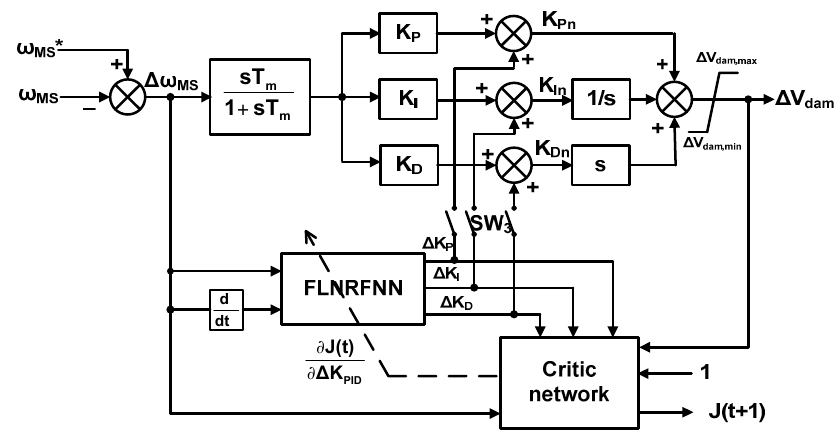
Figure 3. Proposed NIDC for the STATCOM.